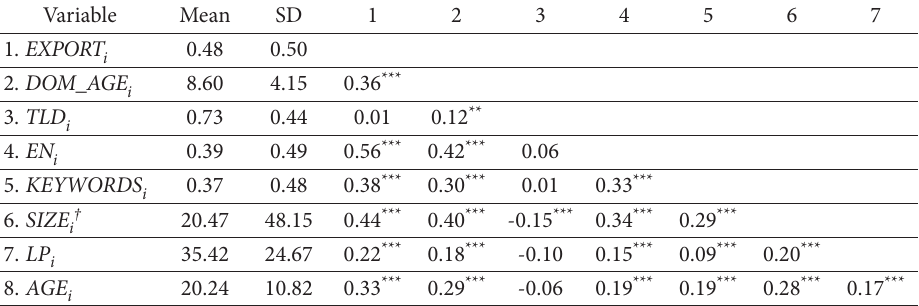
Table 1. Descriptive statistics and correlation matrix